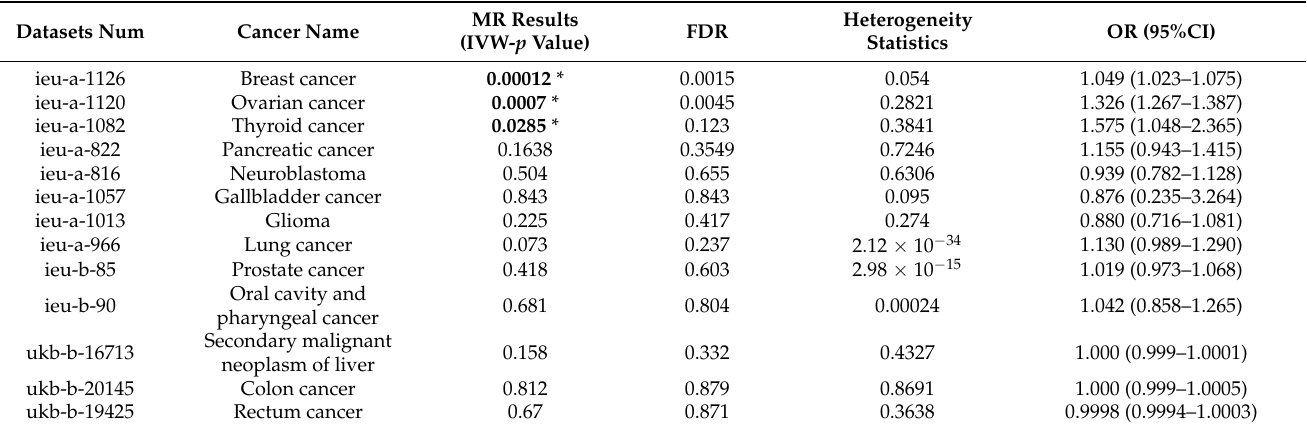
* Bold fonts represent the best experimental results. FDR: false discovery rate; Significance symbol conventions are *: p <